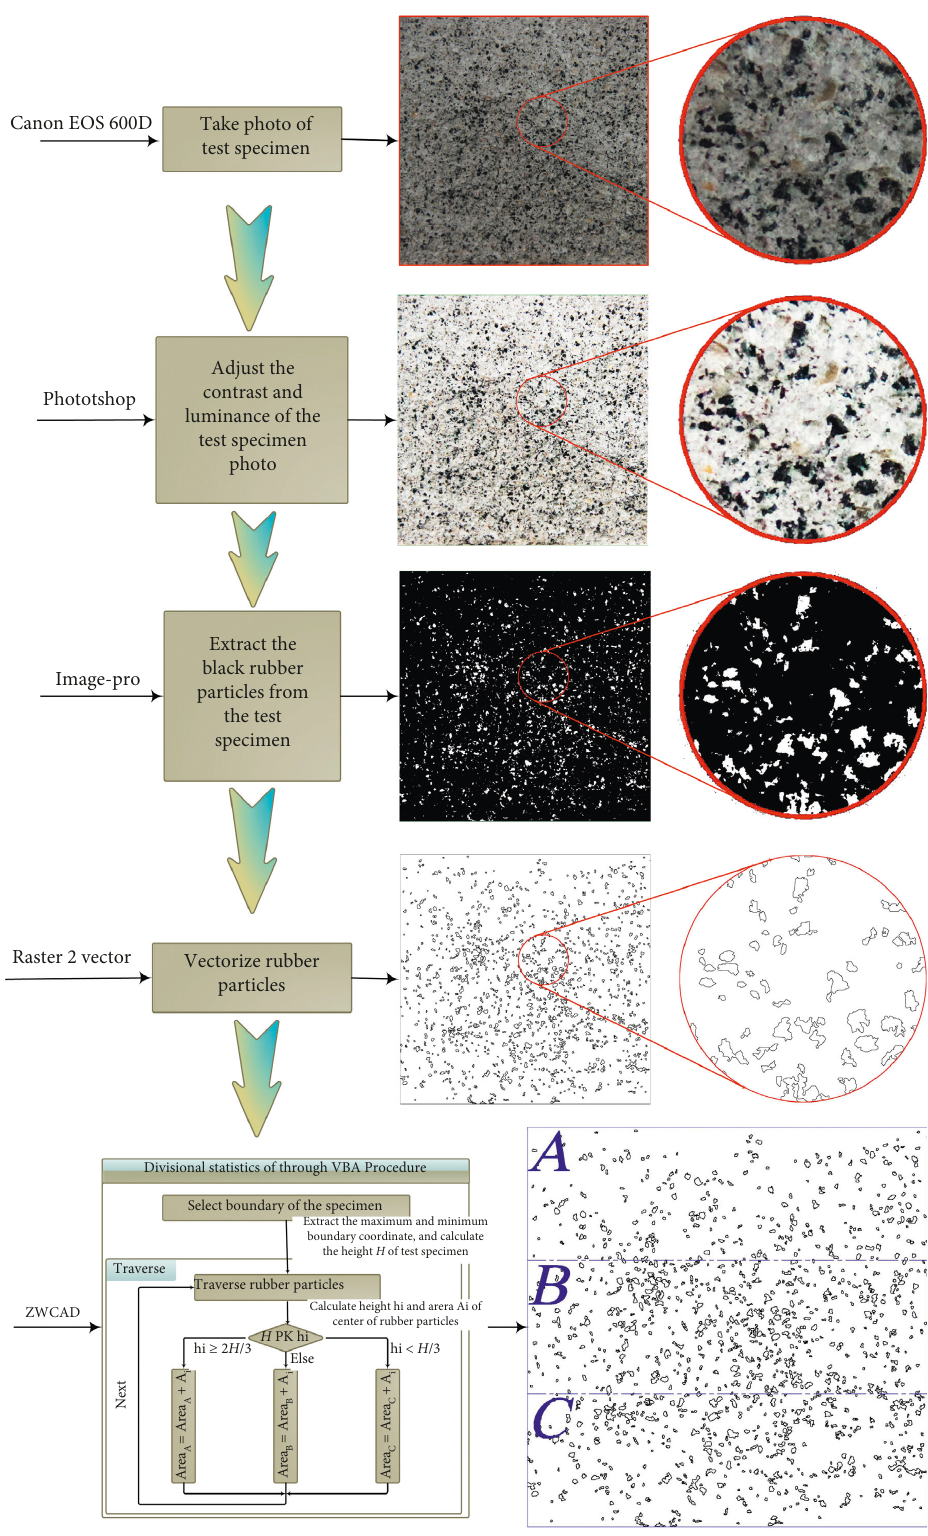
Figure 3: Flowchart of calculation of rubber